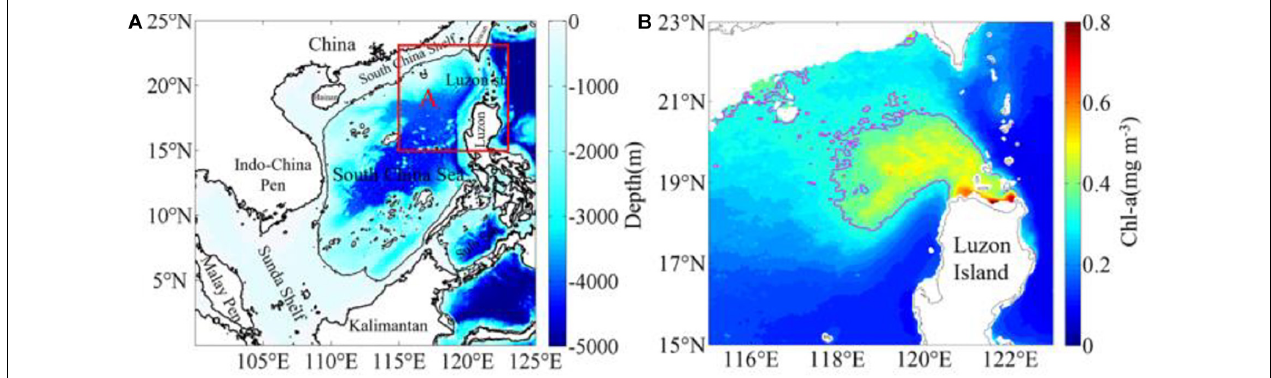
FIGURE 1 | (A) Map of the South China Sea with the 200-m isobath; (B) the winter (December–February) mean chlorophyll- a (mg m − 3 ) concentration in the study region. The magenta contour, the Chl- a isoline of 0.35 mg m − 3 , and the Chl- a data in the (B) is removed where the depth is shallower than 200 m; Box A (15–23 ◦ N, 115–123 ◦ E) in the (A) , is the region of (B)